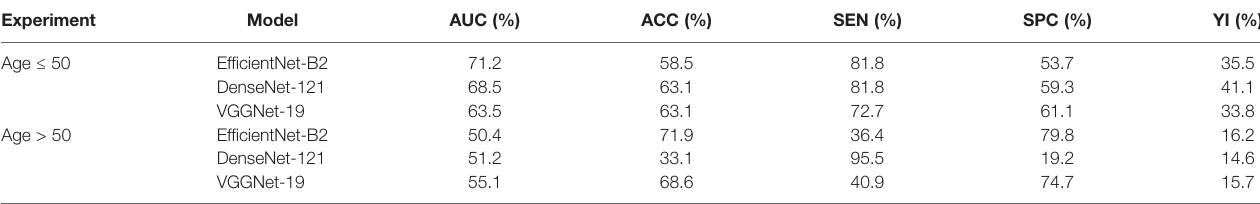
TABLE 5 | Diagnostic performance of deep convolutional neural network model for differentiating triple-negative and non-triple-negative subtypes based on patient age in the main cohort.